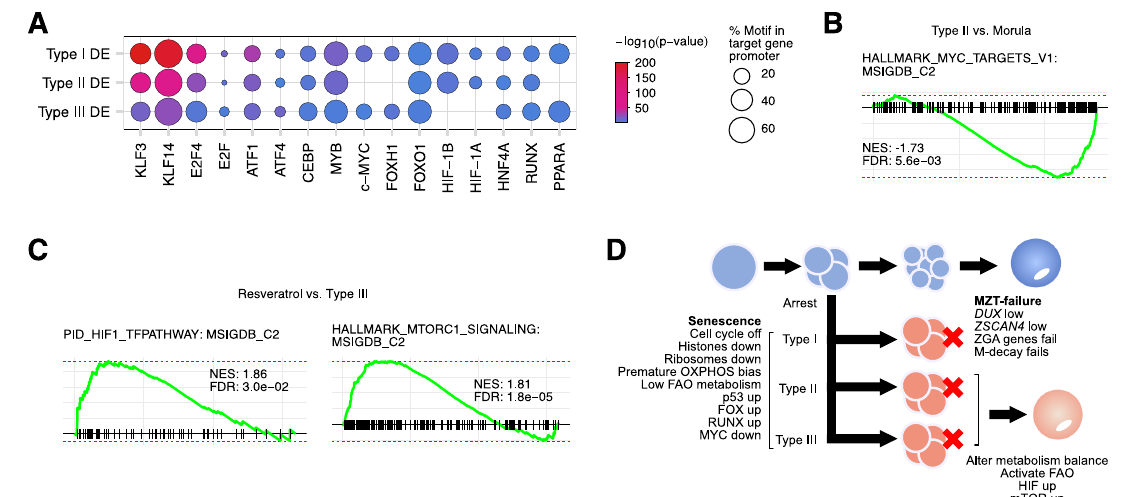
Fig 6. Transcriptional control of embryonic arrest. ( A ) Dot plot for enriched TF motifs in the DE genes in the indicated arrested embryo types. Motif discovery was performed using HOMER with default settings [98] against the promoters (defined here as − 1,000 bp upstream of the TSS) of the DE genes in the indicated types of arrested embryo. The size of the circle indicates the percent of promoters that had the motif, and the color indicates the enrichment p -value. ( B ) GSEA of Type II versus morula, this panel shows the HALLMARK MYC-targets gene set. Underlying data can be found in S5 Data . ( C ) GSEA of resveratrol-treated embryos versus Type III arrested embryos. Underlying data can be found in S5 Data . ( D ) Schematic model of the types of arrest and the underlying pathways driving the arrest. Types I–III cells all enter a senescent-like state, driven by activated p53, and low MYC activity. Histones and ribosomes are down-regulated and cell cycle activity is reduced. Type I arrested embryos harbor an MZT developmental error. Types II and III embryos can be induced to recommence development by modulating SIRT activity. DE, differentially expressed; FAO, fatty acid oxidation; GSEA, gene set enrichment analysis; M-decay, maternal RNA decay; MZT, maternal-to-zygotic transition; OXPHOS, oxidate phosphorylation; TF, transcription factor; TSS, transcription start site; ZGA, zygotic genome activation.